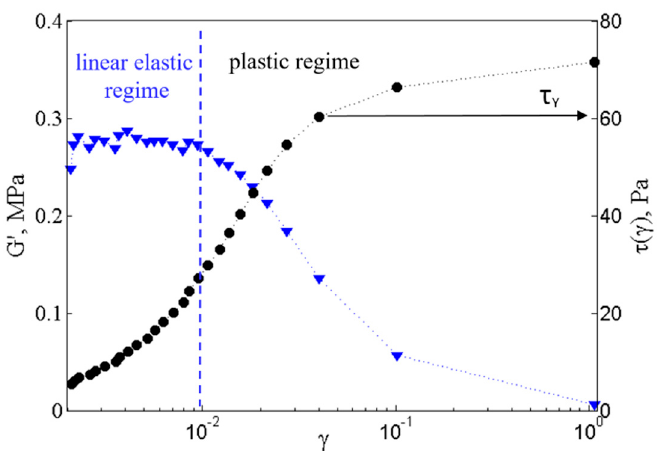
Figure 7. Rheological properties of 1:2 ACC:V suspension of 36% volume fraction. The shear modulus G’ (blue triangle down) and the shear stress τ (black circle) are plotted as a function of the shear strain γ measured through an amplitude sweep at f = 1 Hz. The vertical dashed line delineates the elastic and the plastic regimes. The horizontal plain line indicates the value of the yield stress defined as the value of the shear stress.